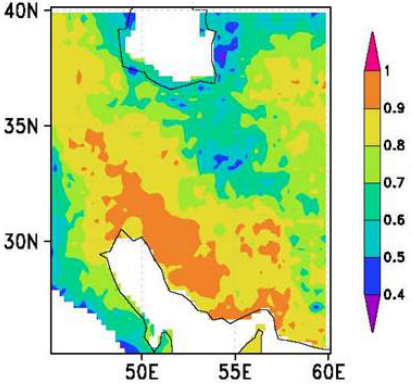
Fig. 9. Comparison of monthly areal precipitation average over Iran (25°-40° N, 45°-60° E) in IS0902 (blue solid line) and TRMM_3B42 (red dashed line) from 1998 to 2006. Fig. 8. Spatial distribution of temporal correlation of average annual rainfall in IS0902 and TRMM_3B42 from 1998 to 2006.